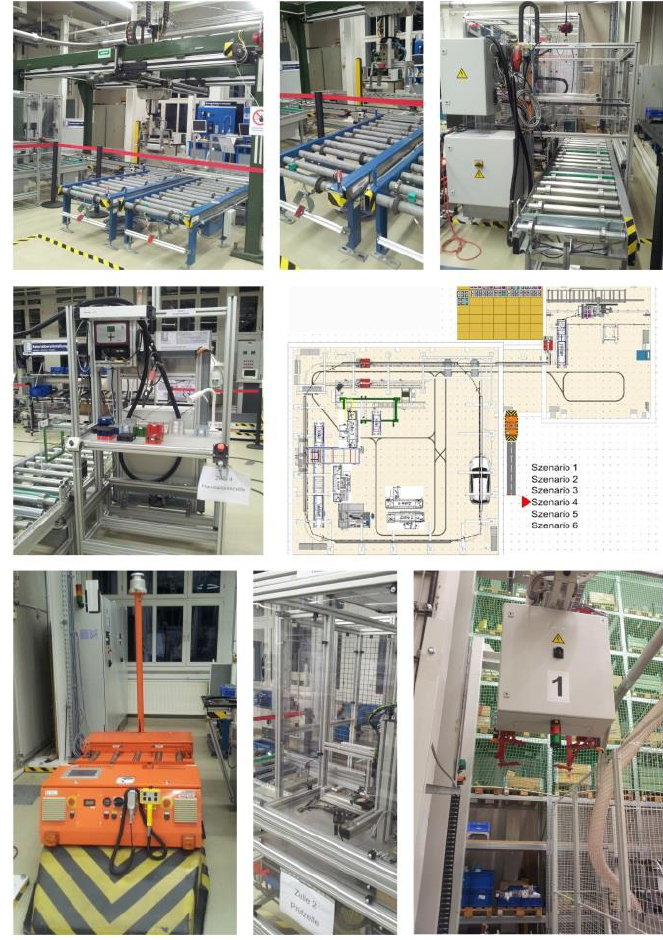
Figure 4. EDF Figure 4. EDF areas .